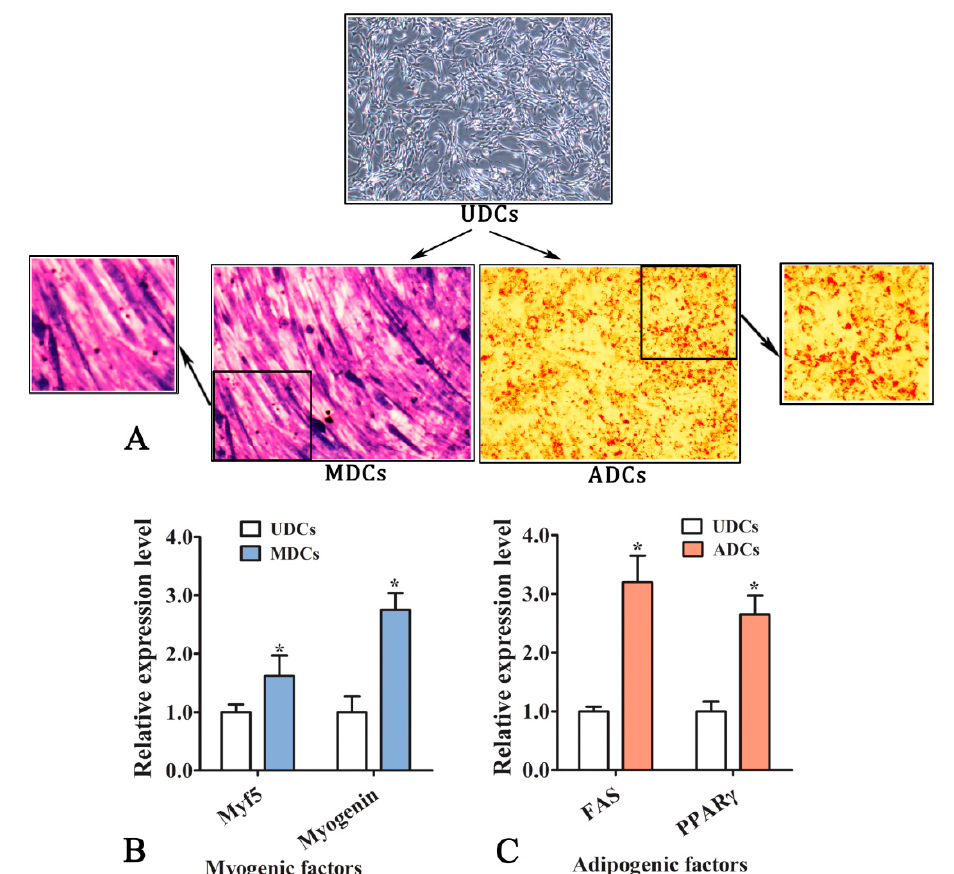
Figure 1. The myogenic differentiation and the adipogenic transdifferentiation of C2C12 myoblasts. ( A ) Morphological difference between adipogenic differentiated cells (ADCs) and myogenic differentiated cells (MDCs). MDCs are stained with Giemsa after six days of the myogenesis differentiation induction, and ADCs are stained with Oil red O after eight days of the adipogenesis differentiation induction. UDCs, undifferentiated cells. ( B ) Relative mRNA levels of the myogenic genes in MDCs and UDCs. ( C ) Relative mRNA levels of the adipogenic genes in ADCs and UDCs. The expression levels were detected by qRT-PCR, n = 5. The data are presented as the means ± SEM. * P ≤ 0.05, student’s t -test.